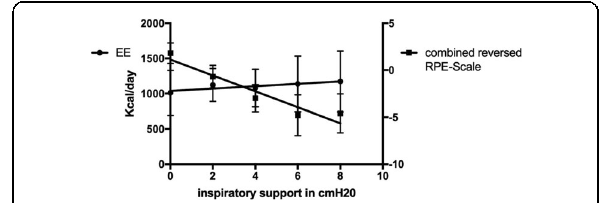
Fig. 1 (abstract 001208). See text for